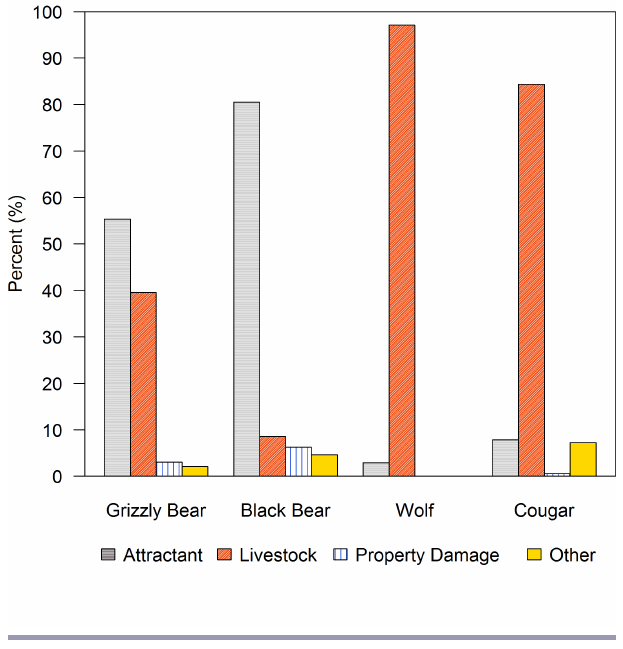
Fig. 5 . Average distance in meters of occurrence records from the public land boundary by species and year (wolf, Canis lupus ; cougar, Puma concolor ; black bear, Ursus americanus ; and grizzly bear, Ursus arctos ). Data are from southwestern Alberta, Canada.